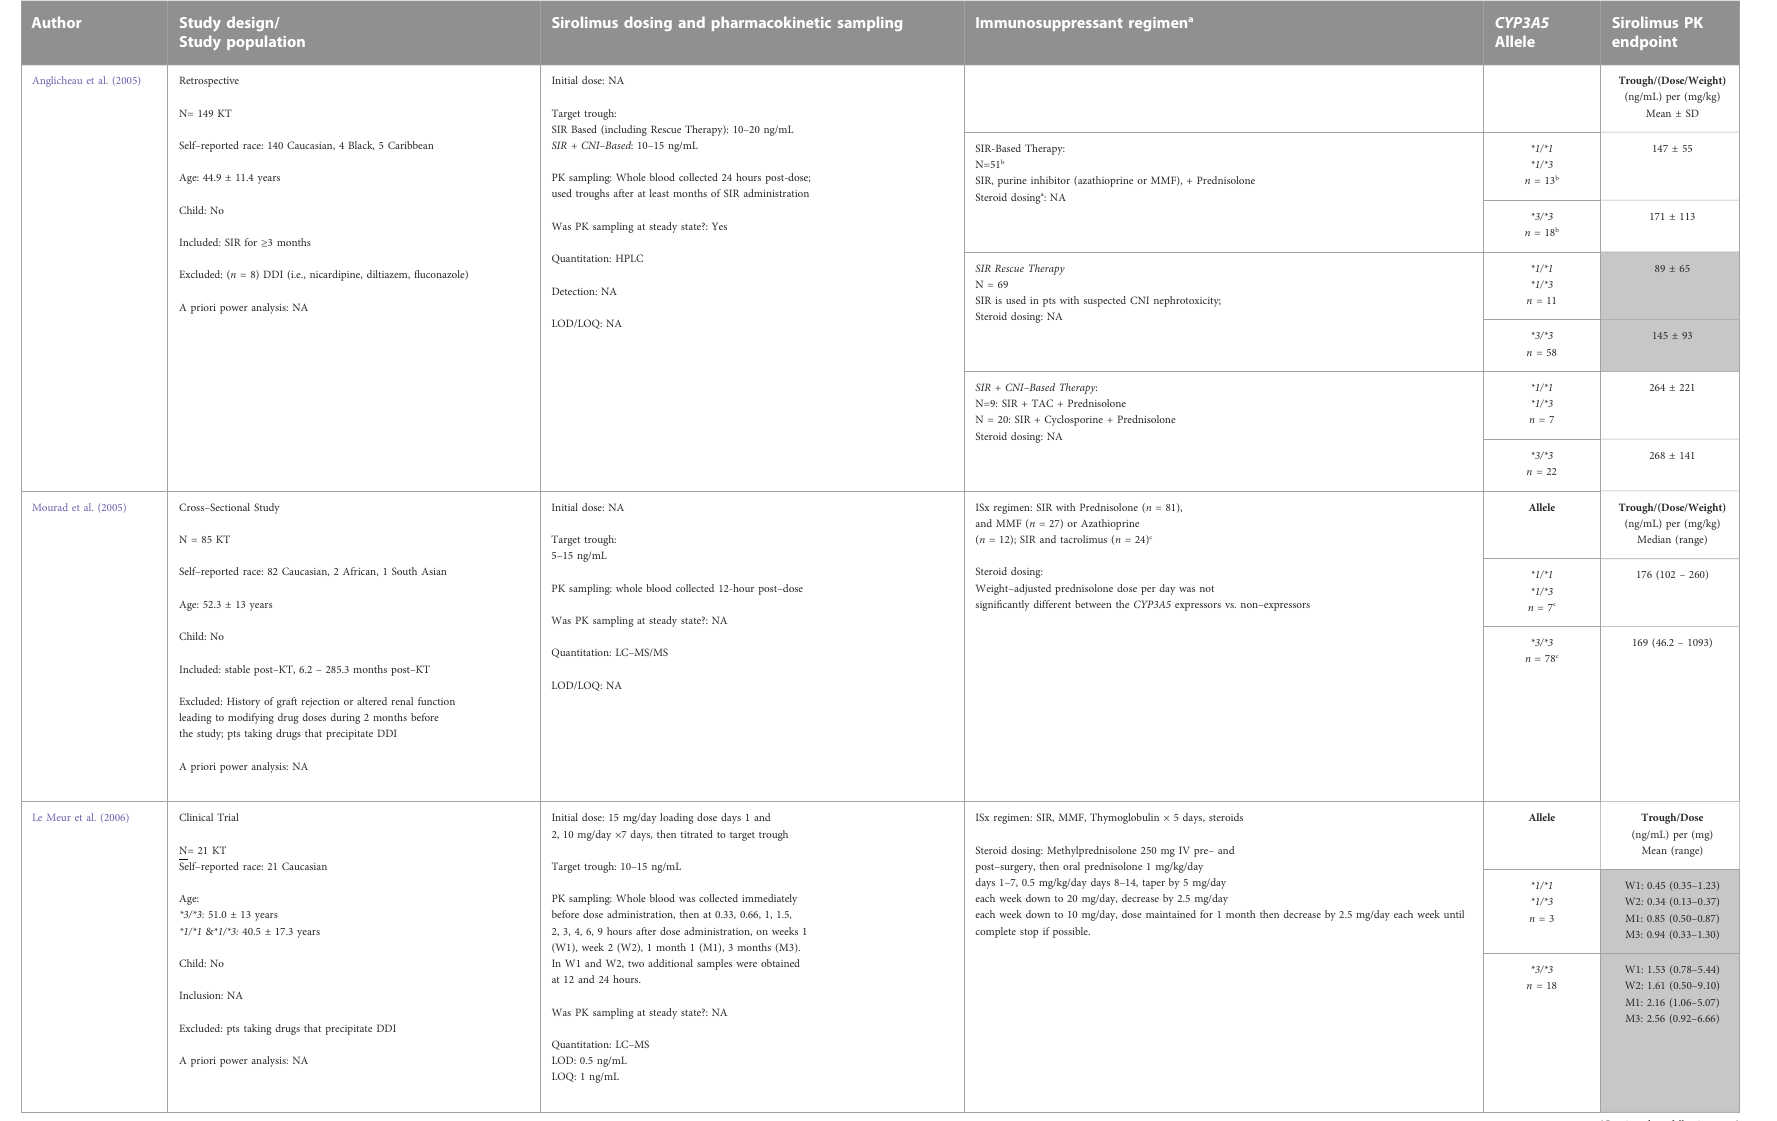
TABLE2Pharmacogenetic association of CYP3A5 rs776746genotypewithsirolimuspharmacokinetics. Publicationsareorganizedinorderofpublication date,startingwiththeoldest.Gray-shadedcellsshowresultswherethe CYP3A5 genotype was associated with a statistically signi fi cant difference ( p < 0.05) in sirolimus